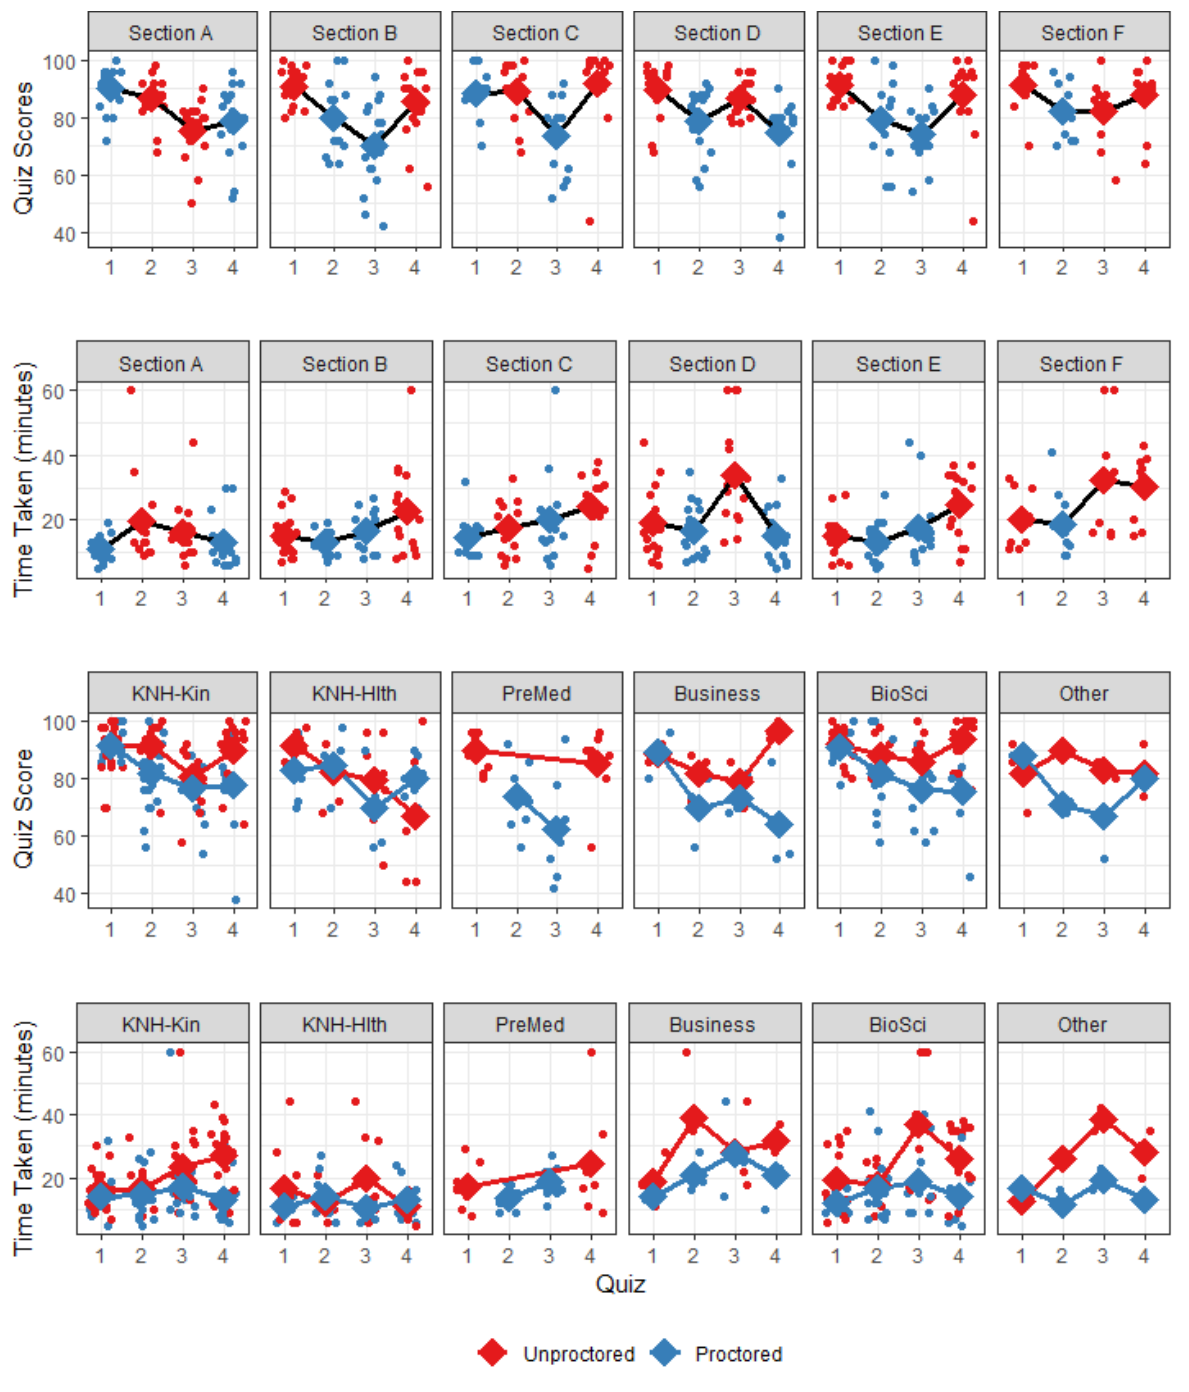
Figure 2 . Four different quiz scores by section, quiz times taken by section A-F, quiz scores by major, and quiz times taken by